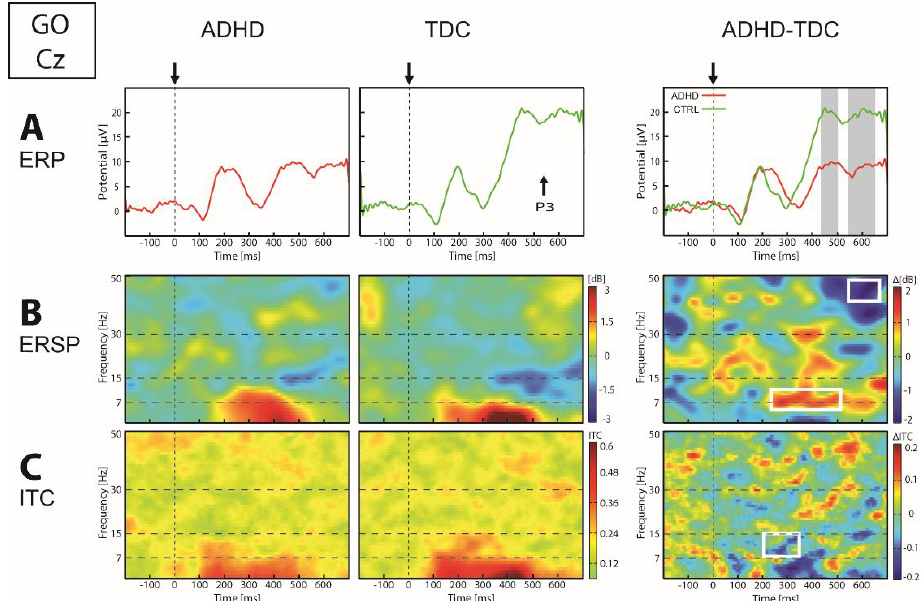
Figure 4. ERP ( A ), ERSP ( B ) and ITC ( C ) in Cz electrode in response to Go stimulus. On the ERP panel: arrows and vertical dot lines indicate stimulus onset, vertical gray bands indicate significance p < 0.05. On the ERSP and ITC panel: vertical dotted line indicate stimulus onset, horizontal dotted lines define frequency bands, and white square indicate significance p < 0.05.